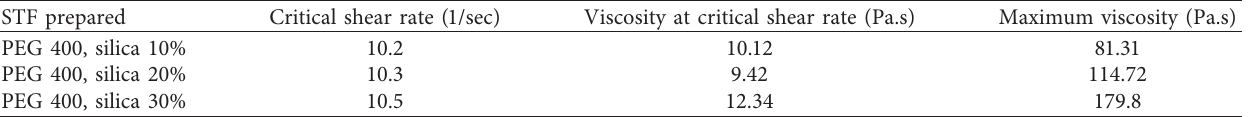
Figure 7: Viscosity curves of STFs containing distilled water at varying starch concentrations Table 1: Rheological specifications of STFs prepared with nanosilica and PEG 400g/mole.